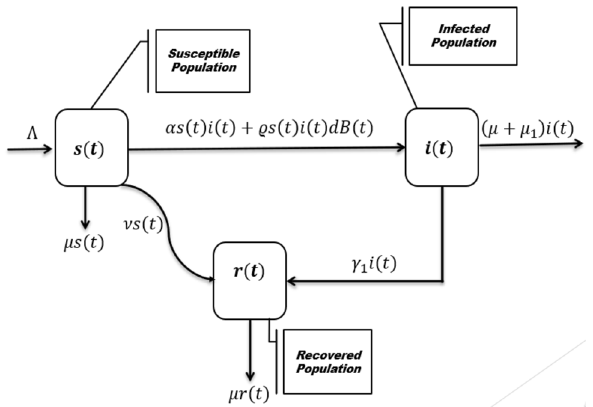
Figure 1. The graph demonstrate the evolution and schematic process of the novel corona virus